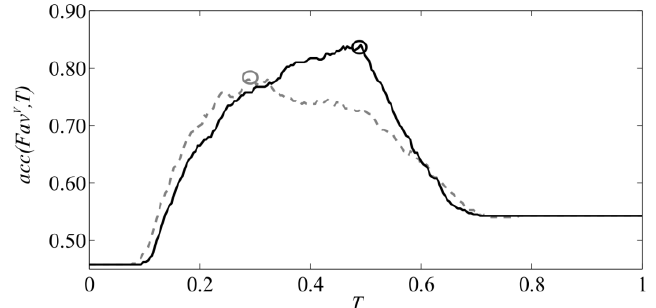
Figure 7. Graph of acc ( Fav V , T ) computed for images captured by machine vision camera: before normalization (dashed line), after automatic normalization (solid line).